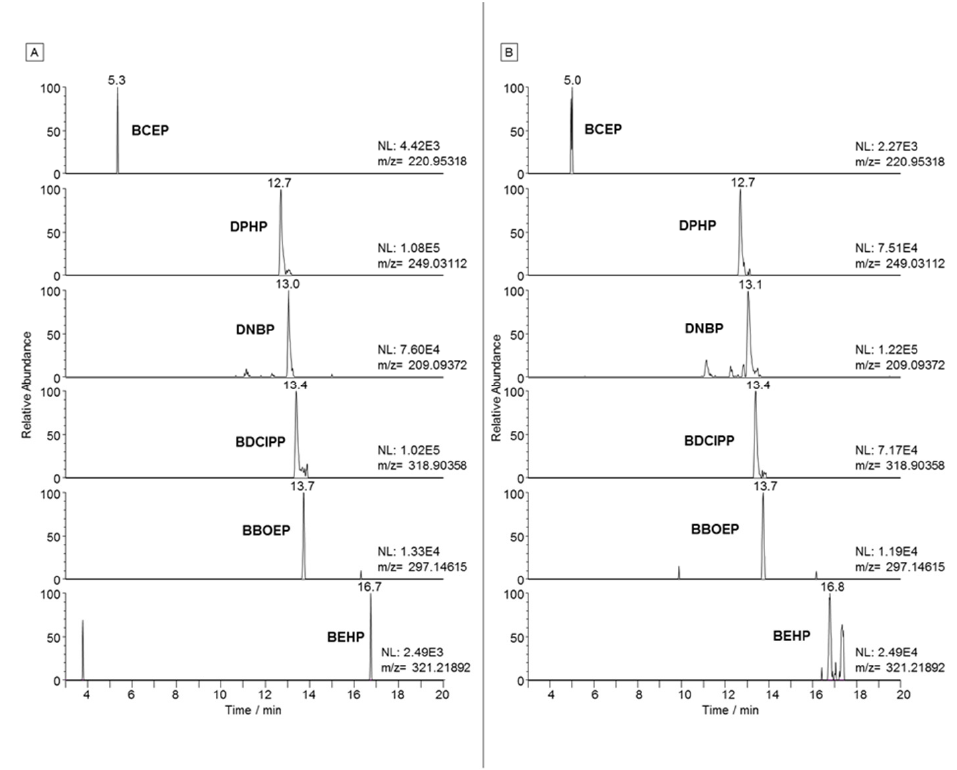
Figure 3. LC-HRMS extracted ion chromatograms of a hake ( A ) and mackerel ( B ) samples spiked